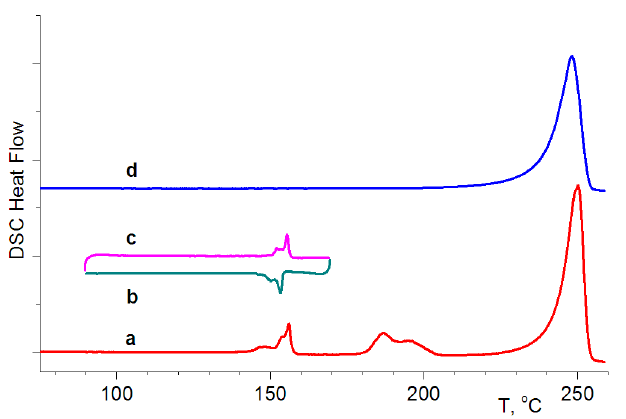
Figure 4. DSC curves registered at the heating of polymorphs 1a (red, a) and 1b (blue, d): DSC curves c (magenta curve) and b (dark cyan curve) are stage-by-stage cycles of cooling and hearting the 1a polymorph within the temperatures range 90–170 °C. The heating rate is 10 °C min –1 (a,d) and 5 °C min –1 (b,c).